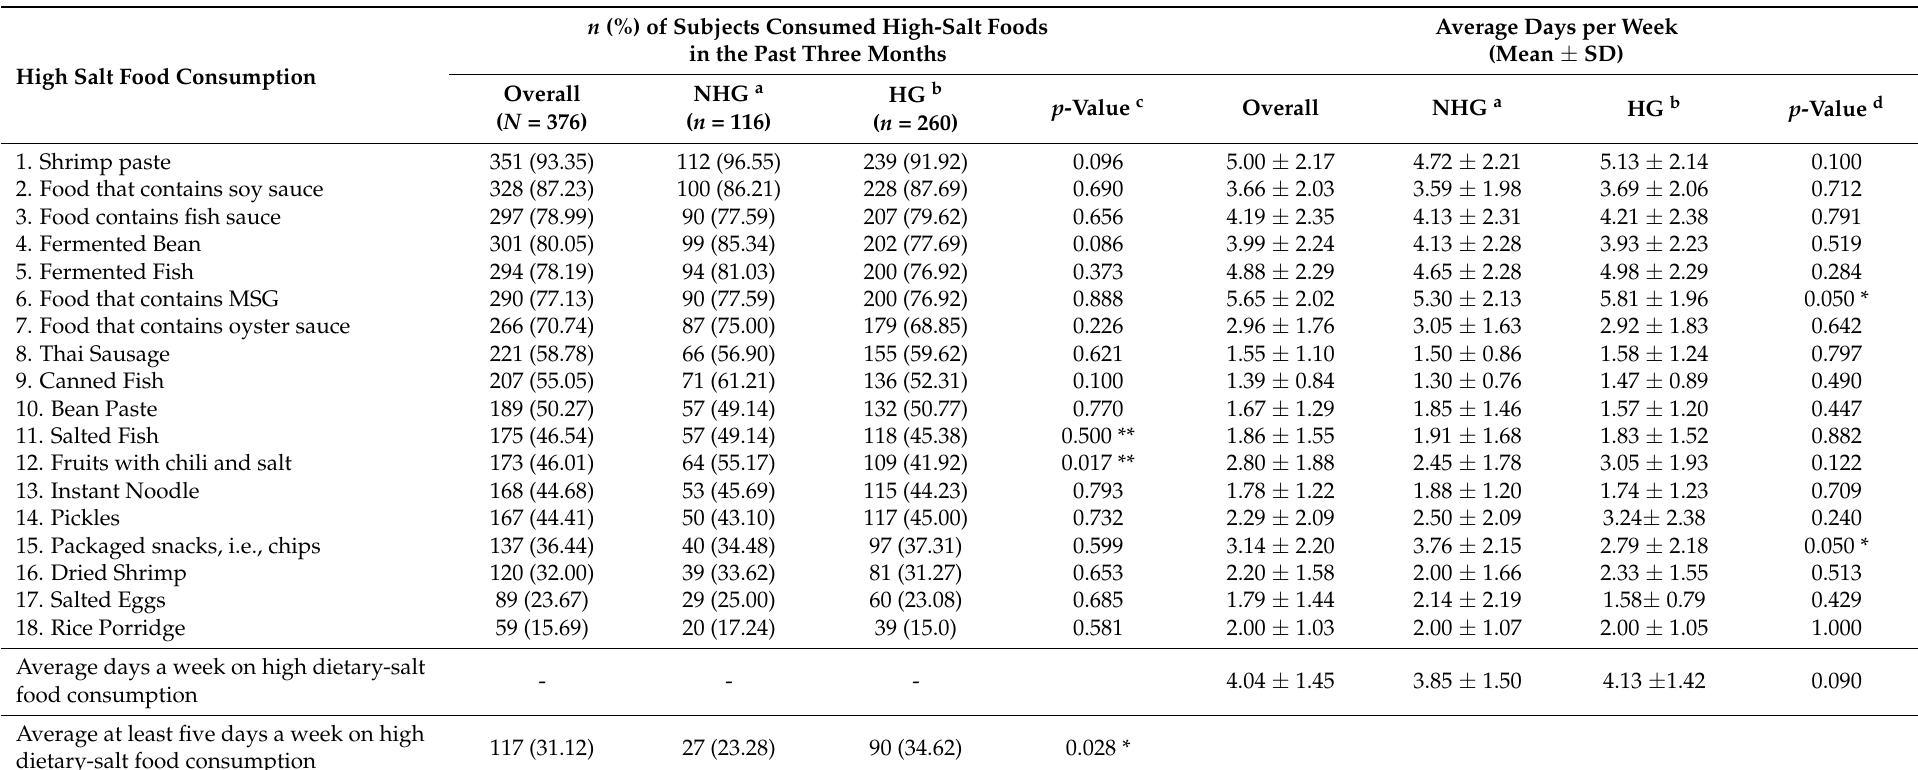
Table 4. High dietary-salt food consumption associated with